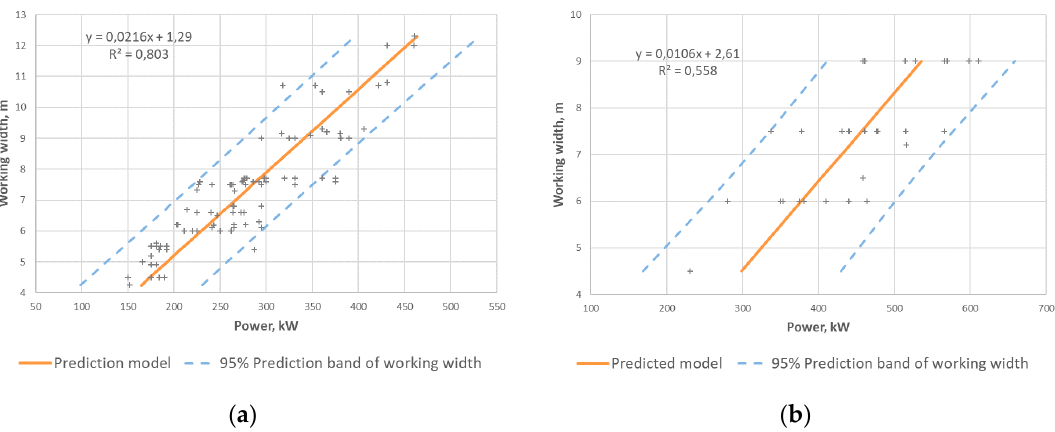
Figure 1. Linear regression models for working width on the base of the used market state for combine ( a ) and forage ( b ) harvesting machines. Table 5. Equation models for response variables (power, weight, working width, price) determined by stepwise regression analysis. Power Adjusted R